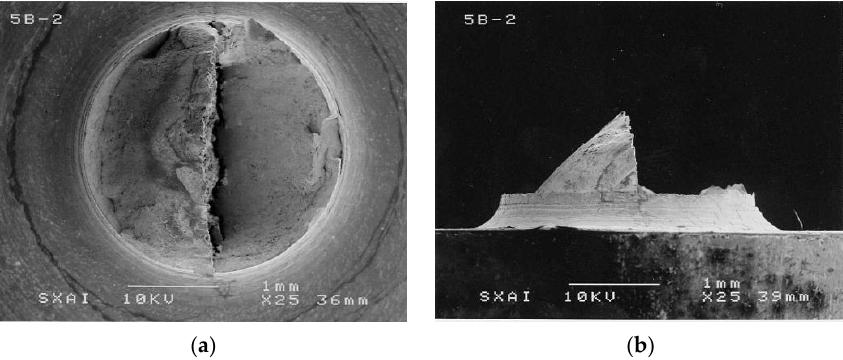
Figure 6. Sample 5B with anisotropic fracture behavior: front view ( a ) and side view ( b ).